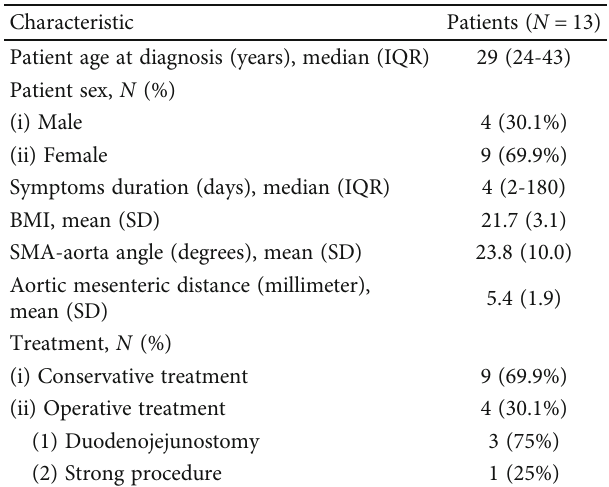
Table 1: Characteristics of patients with SMAS.